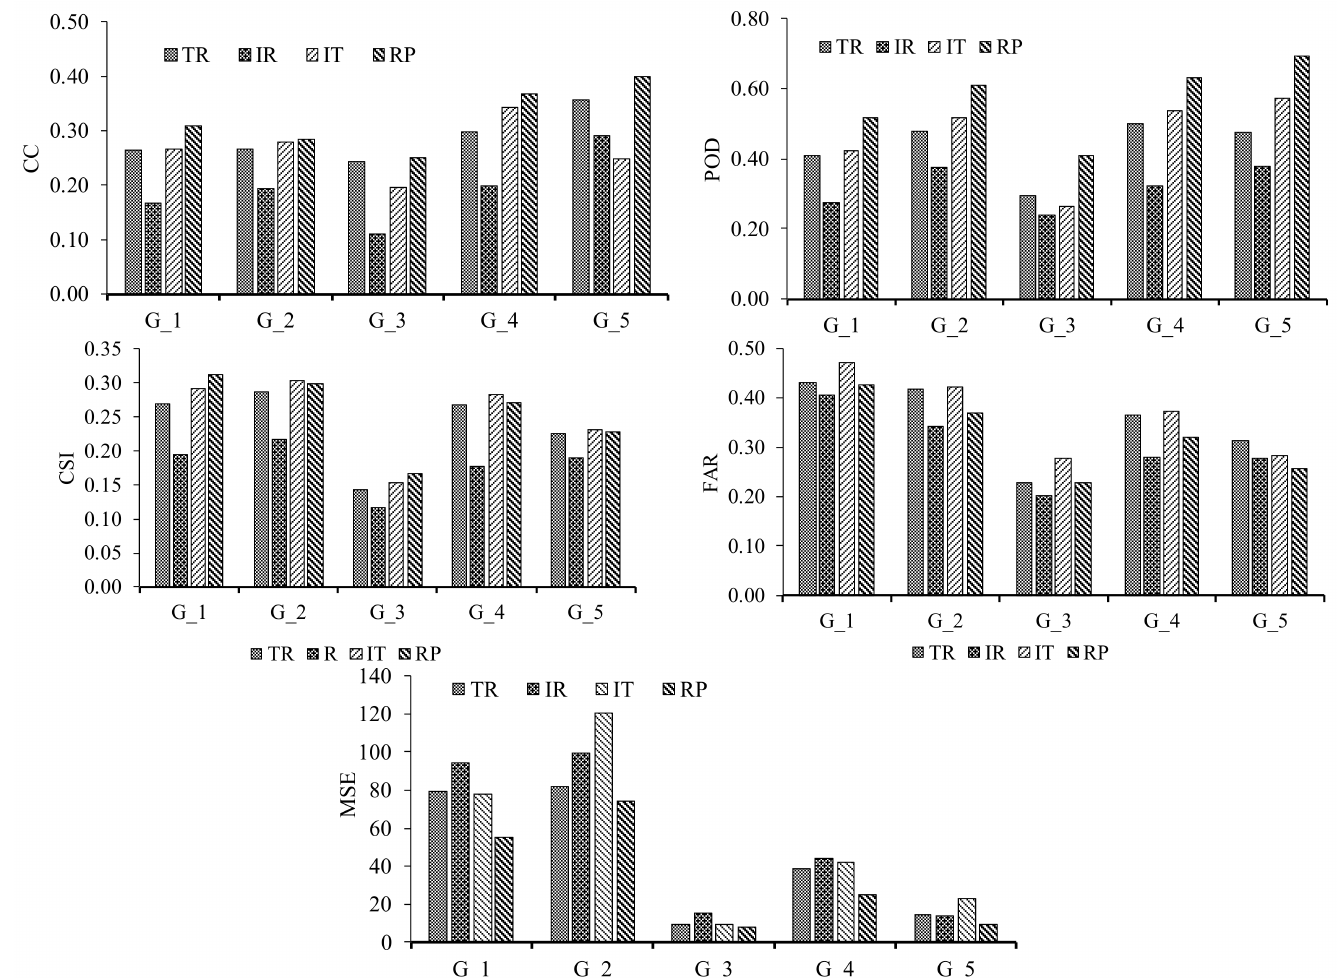
Figure 6. Comparative performance assessment based on the average value of considered evaluation